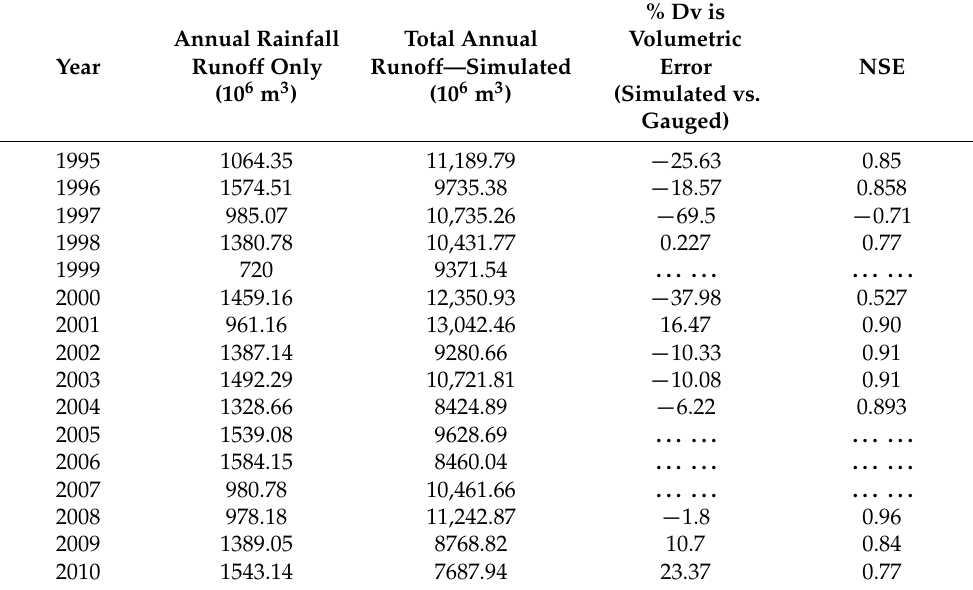
Table 3. Accuracy statistics for SRM simulations during the 1995–2010